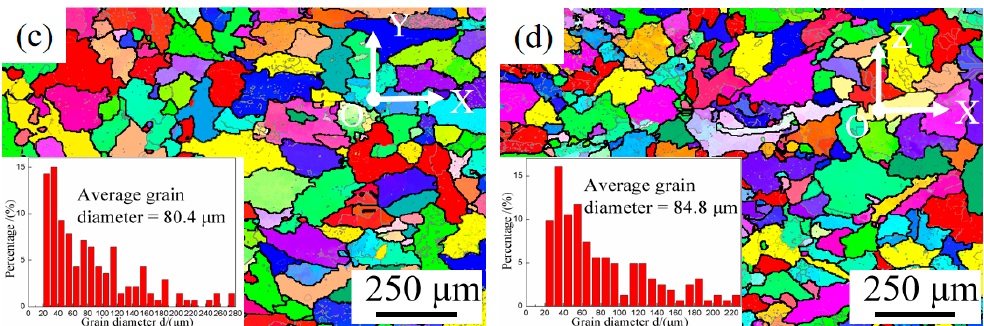
Figure 6. Electron backscattered diffraction (EBSD) graphs and statistical diagrams of grain size distribution of samples in different states: ( a ) face XOY of the as-deposited samples; ( b ) face XOZ of the as-deposited samples; ( c ) face XOY of the T6 heat-treated samples; ( d ) face XOZ of the T6 heat-treated samples.